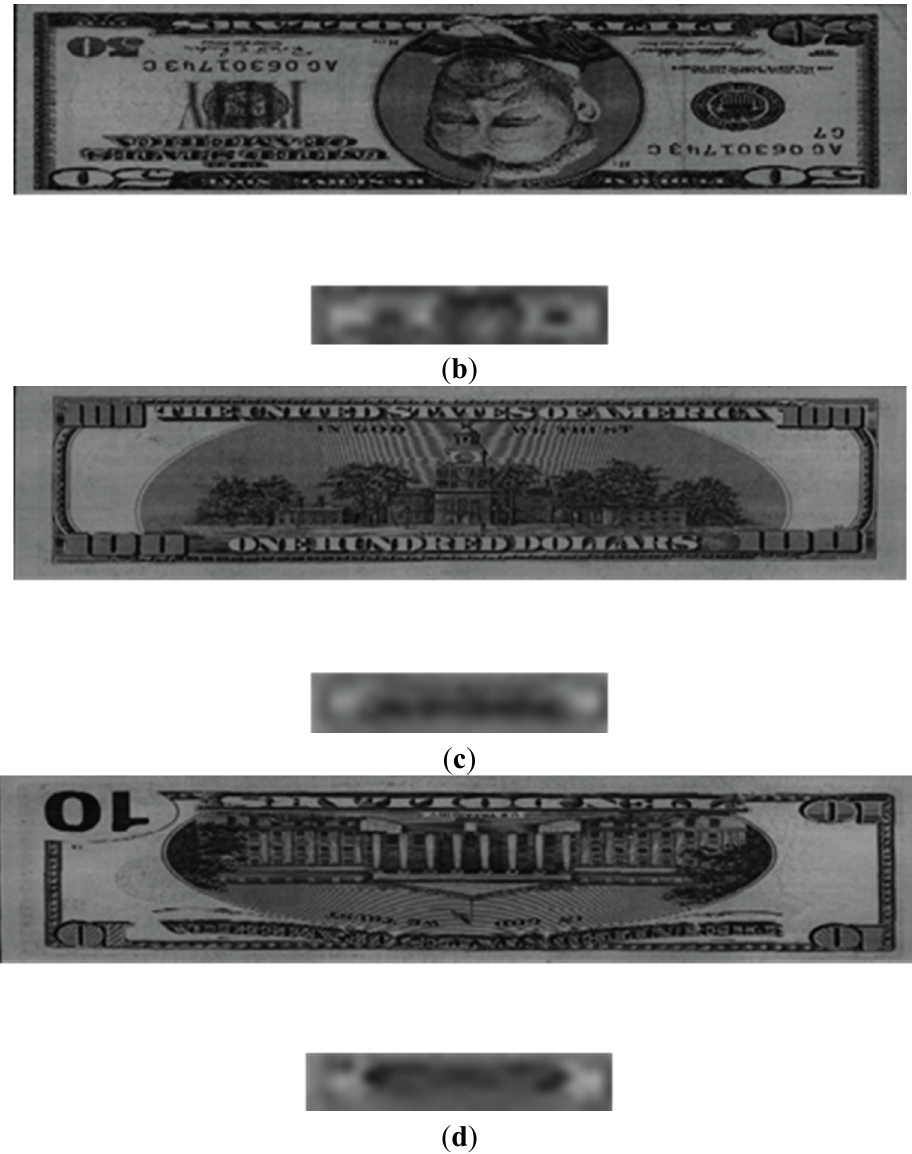
Figure 9. Accurately recognized banknotes and their sub-sampled images: ( a ) Direction A with $100; ( b ) Direction B with recent $50; ( c ) Direction C with recent $100; and ( d ) Direction D with recent